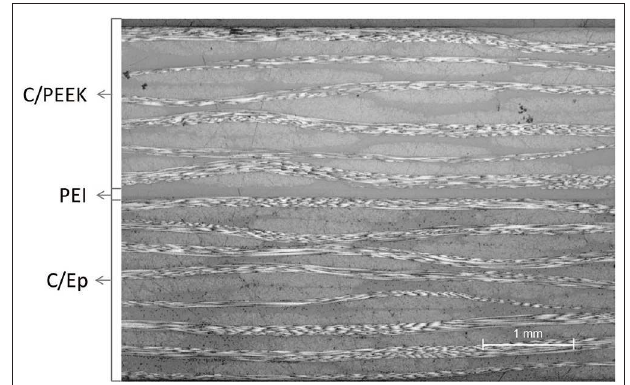
FIGURE 7 | Optical cross-section micrograph of a CF/PEEK to CF/epoxy ultrasonic welded single-lap coupon. The welded joint was achieved through a PEI coupling layer co-cured with the CF/epoxy adherend. Reprinted from Villegas and van Moorleghem (2018) with permission from